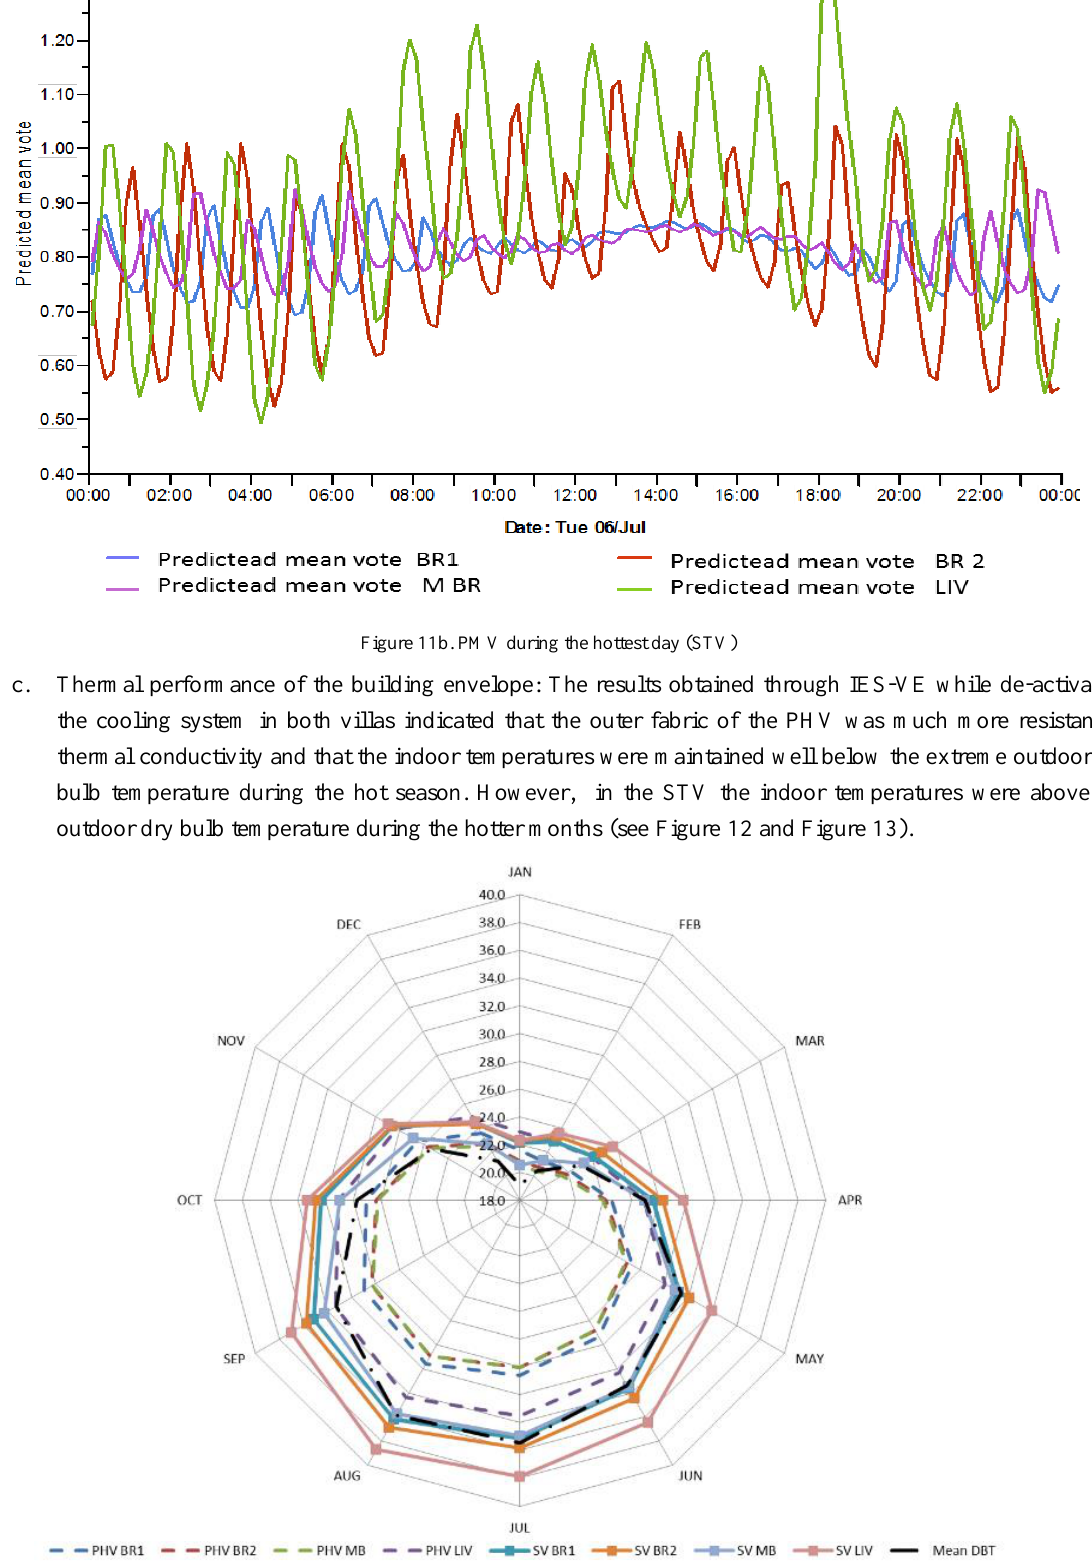
Figure 12. PHV and STV thermal envelope performance in the present